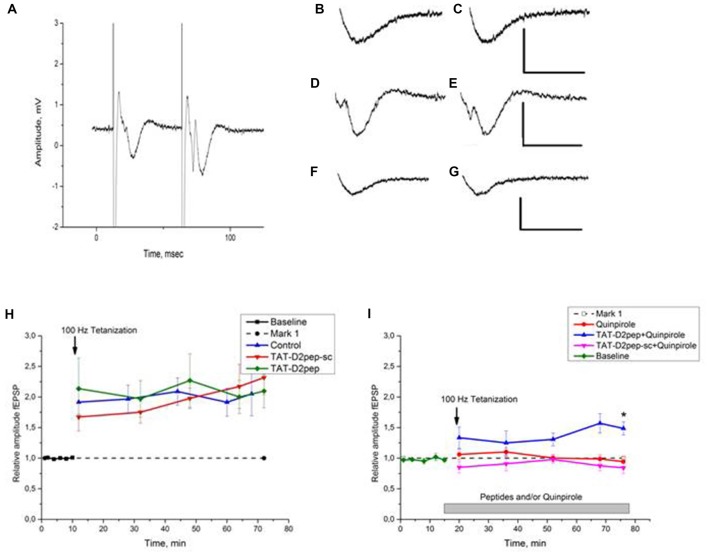
(A–I). Effects of TAT-D2pep on synaptic plasticity of the mouse hippocampal CA1 region. (A) Typical recordings from the mouse hippocampal slice. A representative trace from the CA1 stratum radiatum (paired-pulse test at the stimulus intensity chosen for recording). Interstimulus interval 50 ms. Stimulating bipolar concentric electrode in the Schaffer collateral. (B–G)
Effects of TAT-D2pep-sc, TAT-D2pep and quinpirole on baseline fEPSP responses. Scale: 1 mV, 20 ms; (B–C) representative traces responses before (B) and after (C) 10 min incubation with 10 μM TAT-D2pep-sc, respectively; (D–E) fEPSP before (D) and after (E) 10 min incubation with 10 μM TAT-D2pep; (F–G) fEPSP before (F) and after (G) 10 min incubation with 10 μM quinpirole, respectively. (H)
Effects of TAT-D2pep, TAT-D2pep-sc on fEPSP amplitude in CA1 hippocampal region. Long term potentiation (LTP) was recorded for 2 min, 18 min, 34 min, 50 and 58 min after the stimulation. Baseline: 0–10 min. Control—saline application. Ordinate: relative amplitude fEPSP. The normalized fEPSP amplitude is shown in the presence of 10 μM TAT-D2pep or 10 μM TAT-D2pep-sc before and after application of High frequency stimulation (HFS) protocol (arrow). (I)
Effects of TAT-D2pep, TAT-D2pep-sc and Quinpirole on relative amplitude fEPSP in CA1. The normalized fEPSP amplitude in the presence 10 μM Quinpirole, 10 μM TAT-D2pep or 10 μM TAT-D2pep-sc in different combination after application of HFS protocol (arrow). N = 6–7 mice per group, with 2–3 slices from each animal; *p < 0.05.